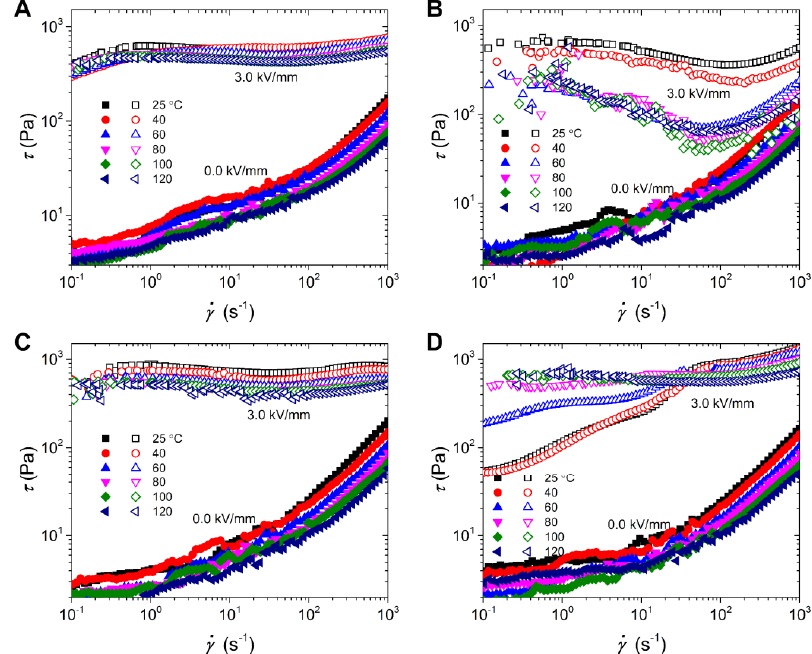
Figure 7. Flow curves of shear stress vs. shear rate for the ER fluids at various temperatures: ( A ) neat PIL, ( B ) PIL / PANI(HCl), ( C ) PIL / PANI(NH 3 ), and ( D ) PIL / PANI(N 2 H 4 ).